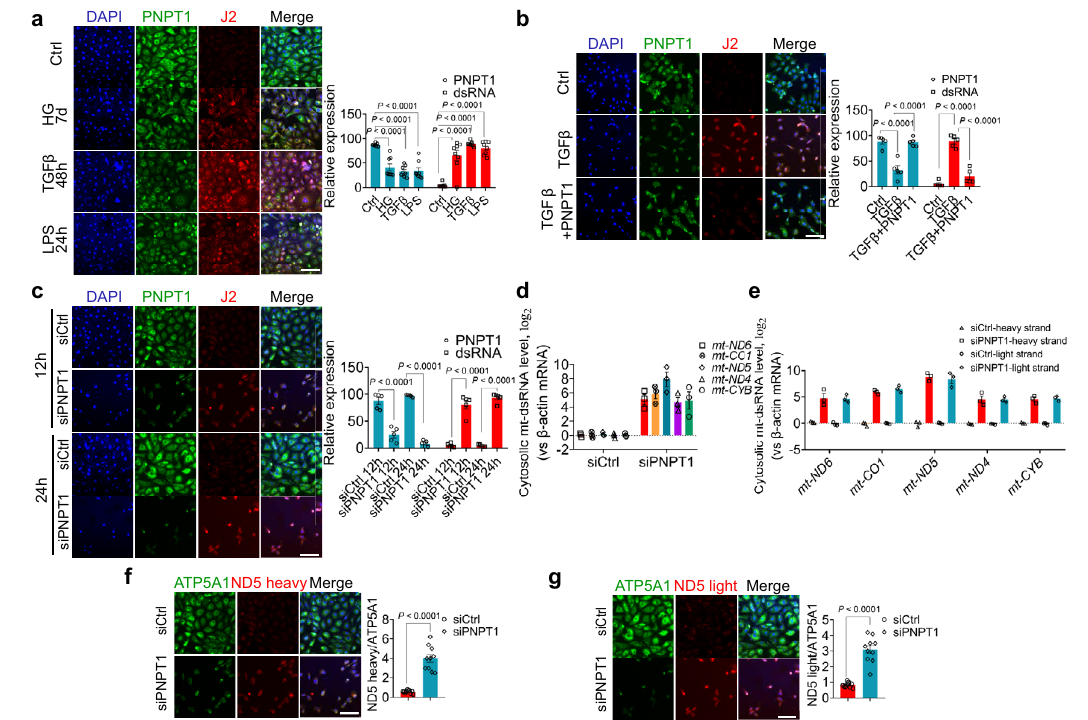
Fig.3|ReductionofPNPT1inhumanrenaltubularHK2cellscausedrelocation of mt-dsRNAs into cytoplasm. a Left: immunostaining of PNPT1 (green) and cytosolic dsRNA (J2, red) in HK2 cells treated with or without HG (40mM, 7d), TGF β 1 (10ng/mL, 48h) or LPS (75 μ g/mL, 24h). Nuclei were stained with DAPI (blue).Right:quanti fi cationofPNPT1andcytosolicdsRNAlevelsinHK2cells. b Left: immunostainingofPNPT1(green)andcytosolicdsRNA(J2,red)inHK2cellstreated with or without TGF β 1 (10ng/mL, 48h). Prior to TGF β 1 treatment, HK2 cells were infectedwithorwithoutPNPT1-expressinglentivirus.Right:quanti fi cationofPNPT1 levels and cytosolic dsRNA in HK2 cells. c Left: immunostaining of dsRNA (J2, red) and PNPT1 (green) in HK2 cells transfected with PNPT1 siRNA-expressing plasmid (siPNPT1) or control oligonucleotide-expressing plasmid (siCtrl). Right: